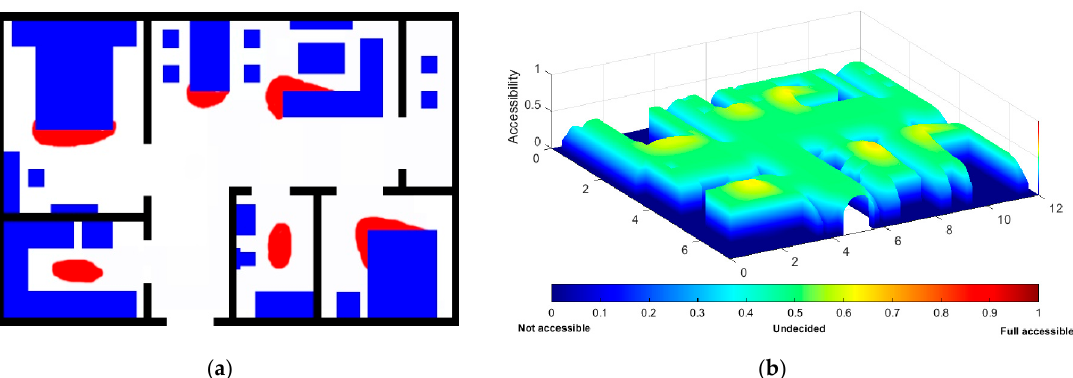
Figure 3. Hot areas related with the furniture layout: ( a ) hot areas related with furniture; ( b ) after processing with the Gaussian function.